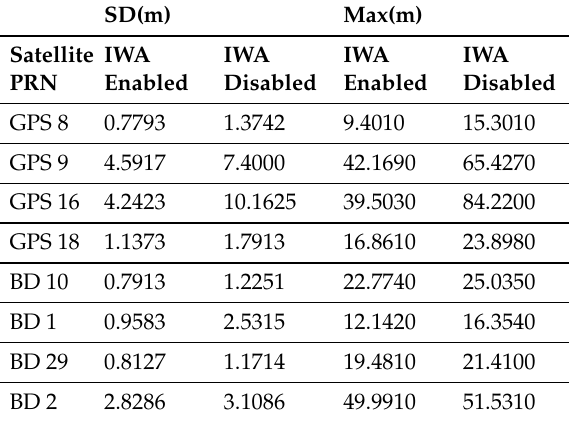
Table 2. Statistical analysis before and after applying INS Aided Pseudo-range Weight Control Algorithm